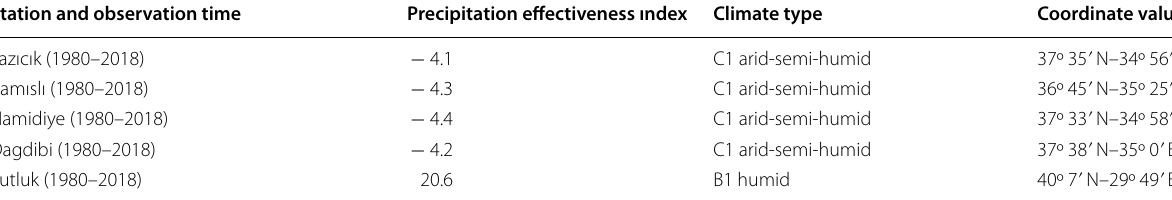
Table 4 Thornthwaite precipitation intensity index